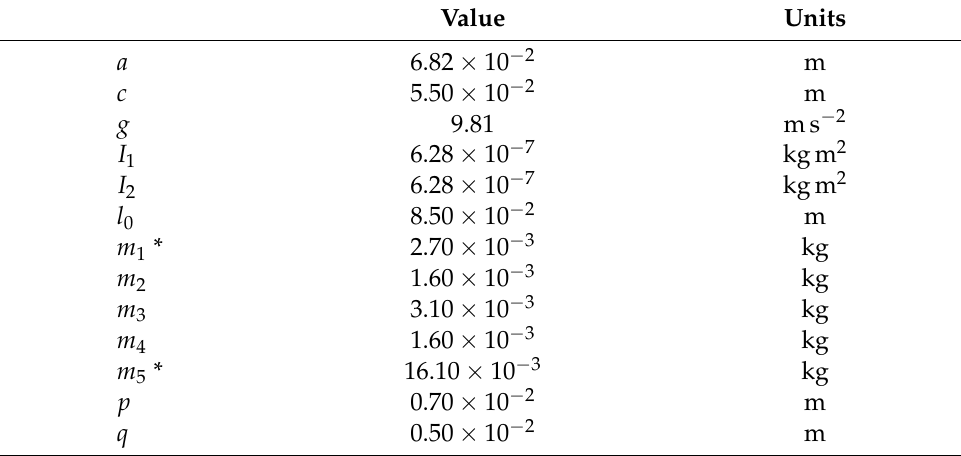
Table 2. Laboratory demonstrator parameters for each element in Figure 4. The total mass of the CLOVER robot is 75.3 10 − 3 ×